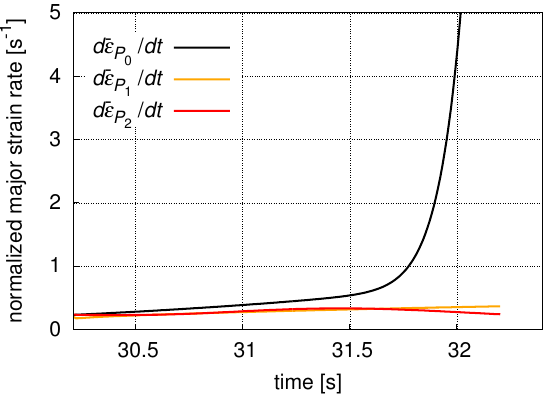
Figure 14. Major strain rates (normalized with respect to the mean uniform strain) during the onset of instability in the necking and non-necking